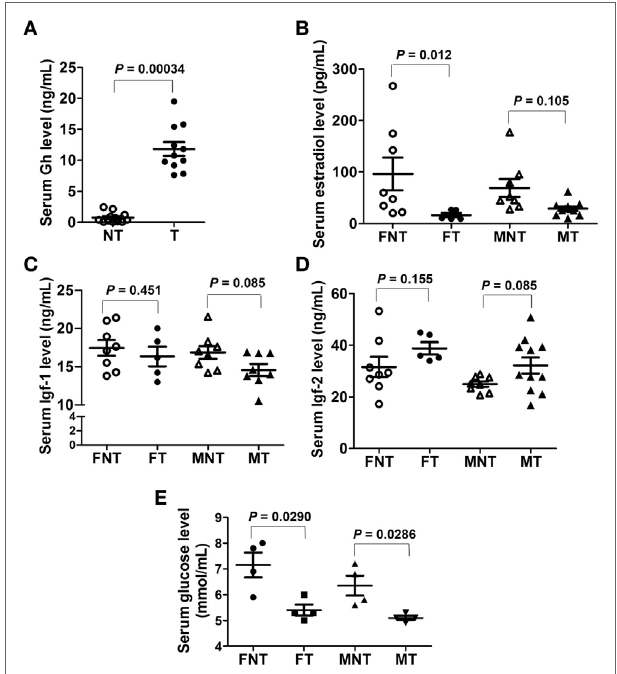
FigUre 3 | Serum levels of (a) Gh, (B) estradiol, (c) Igf1, (D) Igf2, and (e) glucose contents in female (F) and male (M) non-transgenic (NT) and GH-transgenic (T) common carp. The results obtained were analyzed within sex by independent sample t -test. The P -values are indicated on the